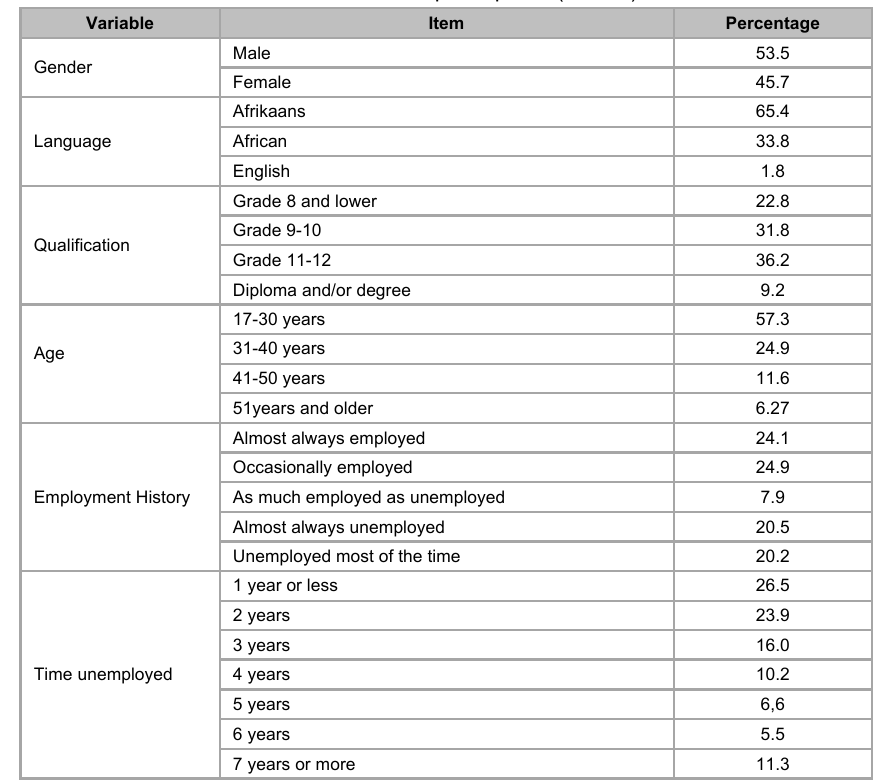
Characteristics of participants ( N